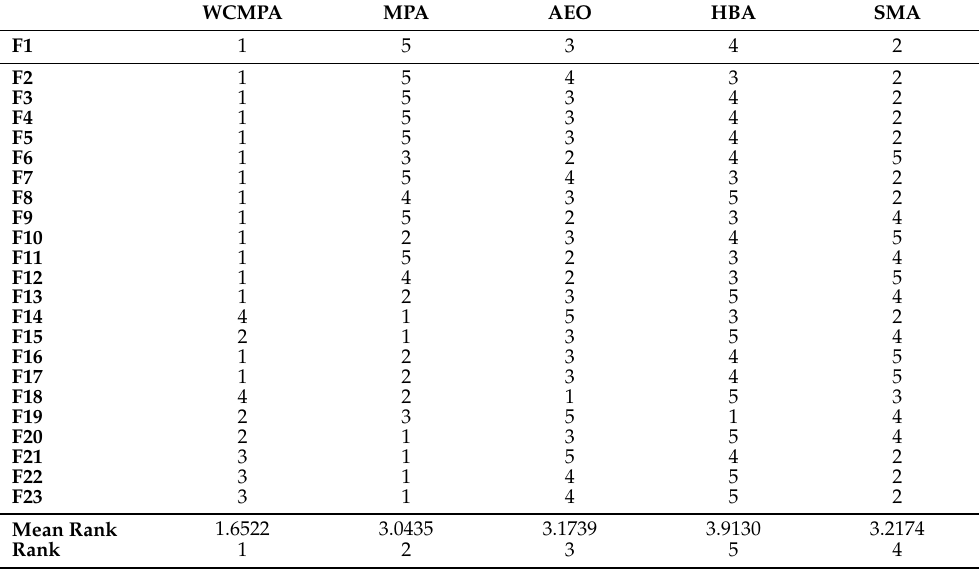
Table 8. Mean absolute error